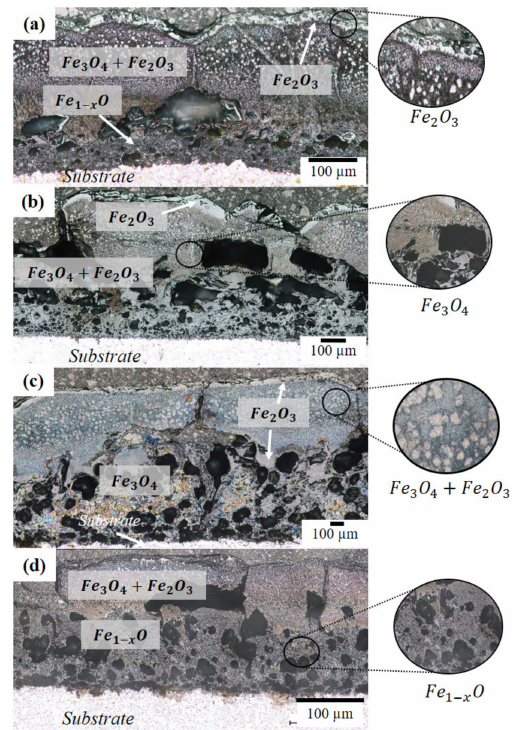
Figure 18. Morphology of oxides formed at ( a ) 1000 ◦ C after 10 min, ( b ) 1100 ◦ C after 60 min, ( c ) 1200 ◦ C after 10 min, and ( d ) 1200 ◦ C after 60 min.